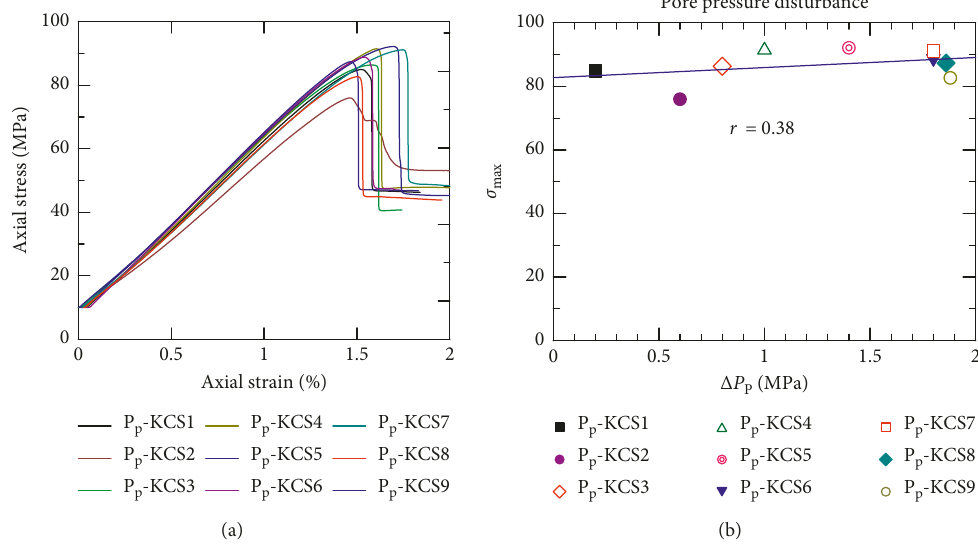
Figure 11: (a) Stress-strain curves and (b) maximum stress ( σ Cretaceous